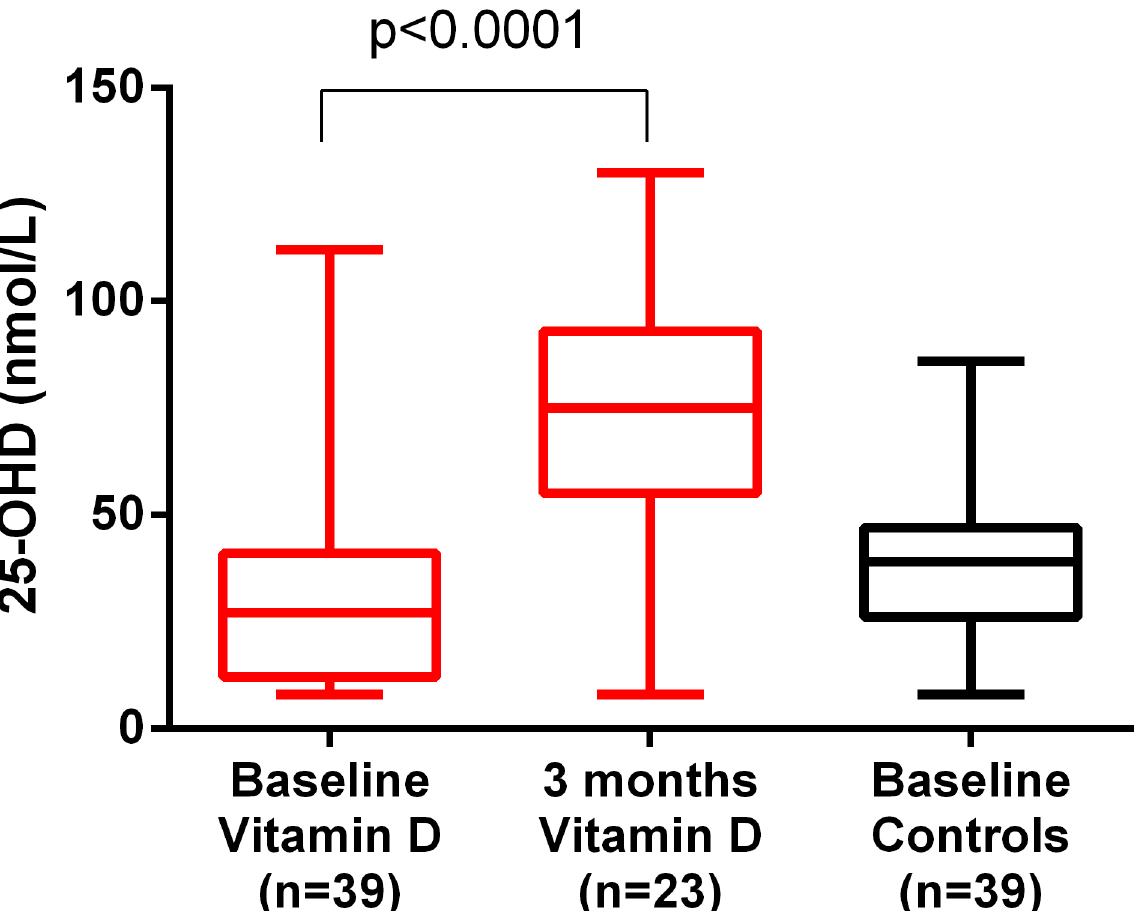
Fig 3. 25-hydroxyvitamin D (25-OHD) levels in the vitamin D (n = 39 and n = 23) and control group (n = 39). There was a significantincreaseof 25-OHD levels in the vitamin D group comparedto baseline; statistical analysiswas performed by using a pairedt-test (p < 0.0001). There was no statistically significantdifference in baselinevalues betweenthe vitamin D and control group. There were no follow-upmeasurements performed in the control group. The lines show medianvalue, the boxes 25–75percentile and whiskers show minimum and